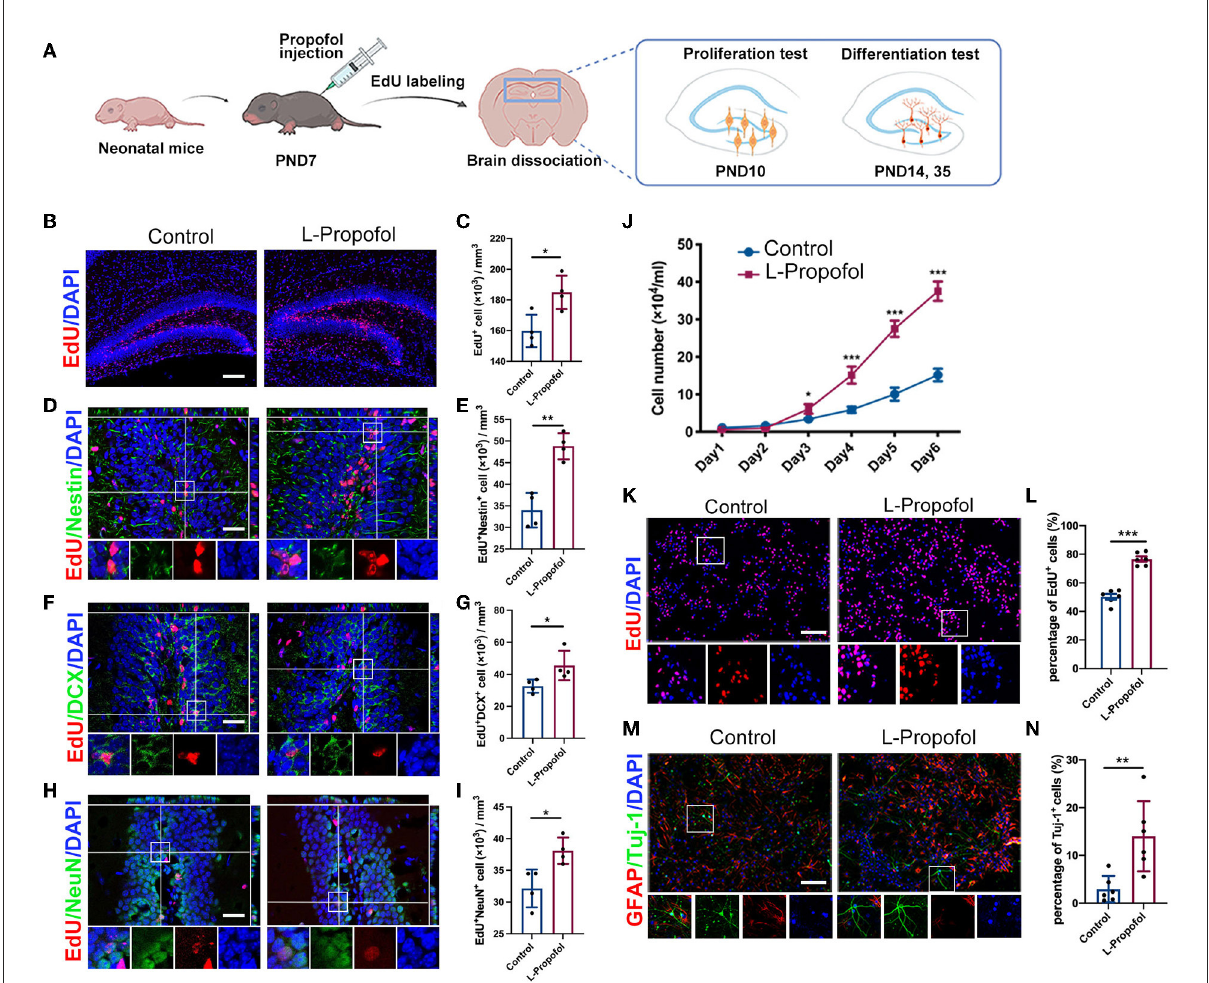
FIGURE2 Long-term tracing showed boosted hippocampal neurogenesis after low-dose Propofol treatment. (A) Timeline for treatment for hippocampal neurogenesis. (B,C) Images of maximum intensity projection (B) and quantification (C) showing the increased EdU + (red) cells ( p = 0.016) in DG of mice at PND 10 in the L-Propofol group. N = 4. Scale bars, 200 µ m. (D,E) Images with z-plane projections (D) and quantification (E) showing the increased Nestin + (green)/EdU + (red) newborn NSCs ( p = 0.001) in DG of mice at PND 10 in the L-Propofol group. N = 4. (F,G) Images with z-plane projections (F) and quantification (G) showing an increased DCX + (green)/EdU + (red) newborn neurons ( p = 0.043) in the DG of mice at PND 14 in the L-Propofol group. N = 4. (G,I) Images with z-plane projections (H) and quantification (I) showing an increased NeuN + (green)/EdU + (red) mature neurons ( p = 0.017) in the DG of mice at PND 28 in the L-Propofol group. N = 4. For (D–I) , Scale bars, 50 µ m. Bottom panels: higher-magnification views of selected regions. (J) Growth curves of NSCs as assessed by direct counting for consecutive 6 days after treatment ( p < 0.001). N = 3. (K,L) Fluorescence images (K) and quantification analysis (L) showing significantly increased EdU + cells in NSCs ( p < 0.001) at 4 days after treatment. Scale bar: 50 µ m. N = 6. (M,N) Fluorescence staining (M) and quantification (N) showing an increased proportion of Tuj-1 + newborn neurons ( p = 0.006) at 10 days after differentiated induction in the L-Propofol group. N = 6. Scale bar: 20 µ m. Error bars, mean ± SD, Bottom panels: higher-magnification views of selected regions. * p < 0.05, ** p < 0.01, *** p < 0.001. Repeated measurement and Student’s t -test were used for